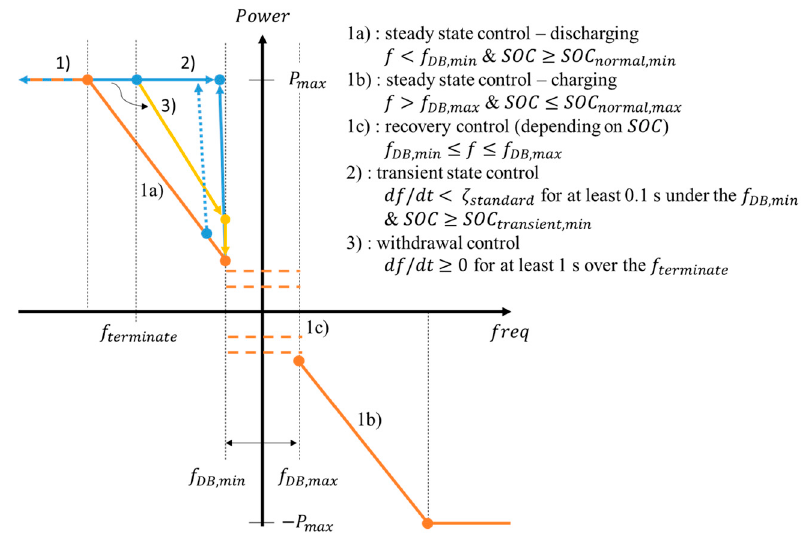
Figure 5. Control strategy of the BESS for providing virtual inertia and primary frequency response.